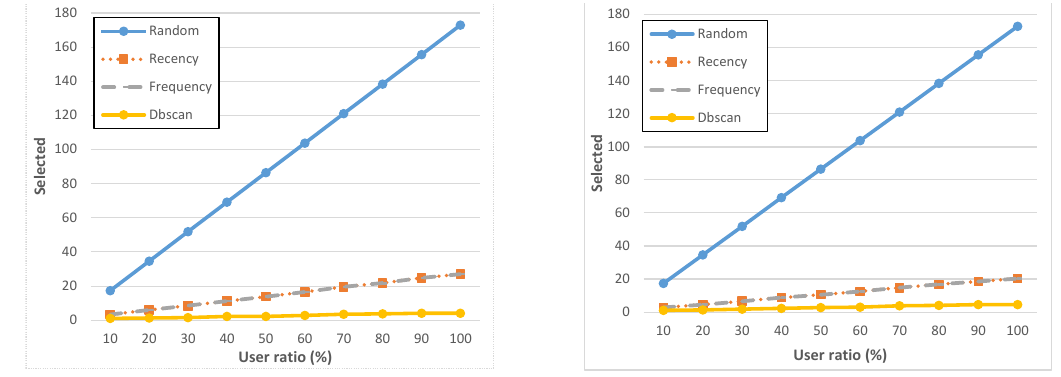
Figure 6. Number of candidates selected by each policy in case of geo-notified ( left ) and non-geo-notified ( right )